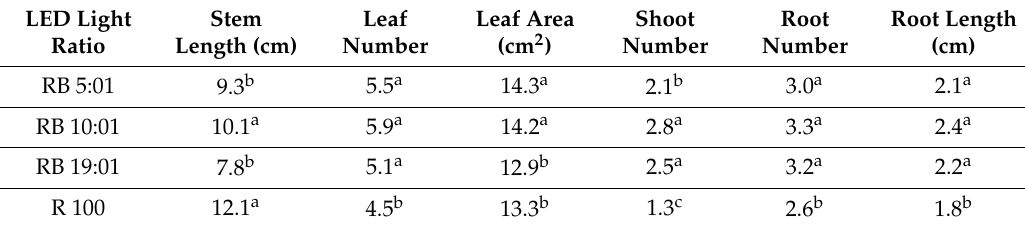
Table 1. E ff ects of various red-blue (RB) light ratios on the growth of tomato plantlets. Table 1. Effects of various red-blue (RB) light ratios on the growth of tomato plantlets.